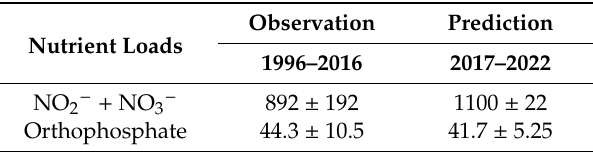
Table 3. Comparison of observed (1996–2016) and predicted (2017–2022) annual mean (NO 2 − + NO 3 − ) and orthophosphate loads (10 3 t /